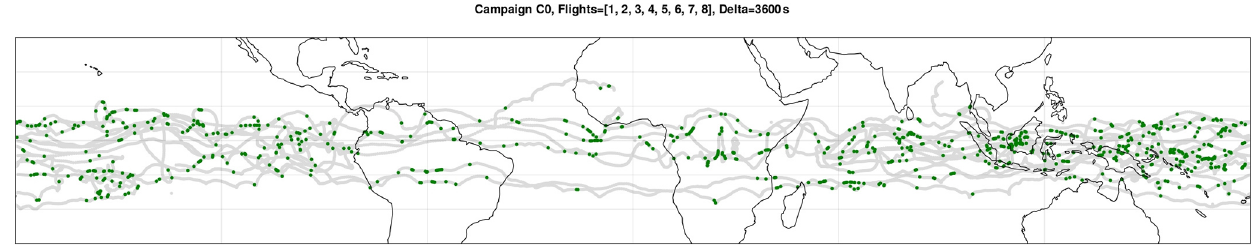
Figure 15. The positions of turbulent patches are shown as green dots for the eight flights of the C0 campaign. Each dot corresponds to a 1h time interval. The detections are based on the Ri TSF criterion. The detected turbulence episodes are far from uniform around the